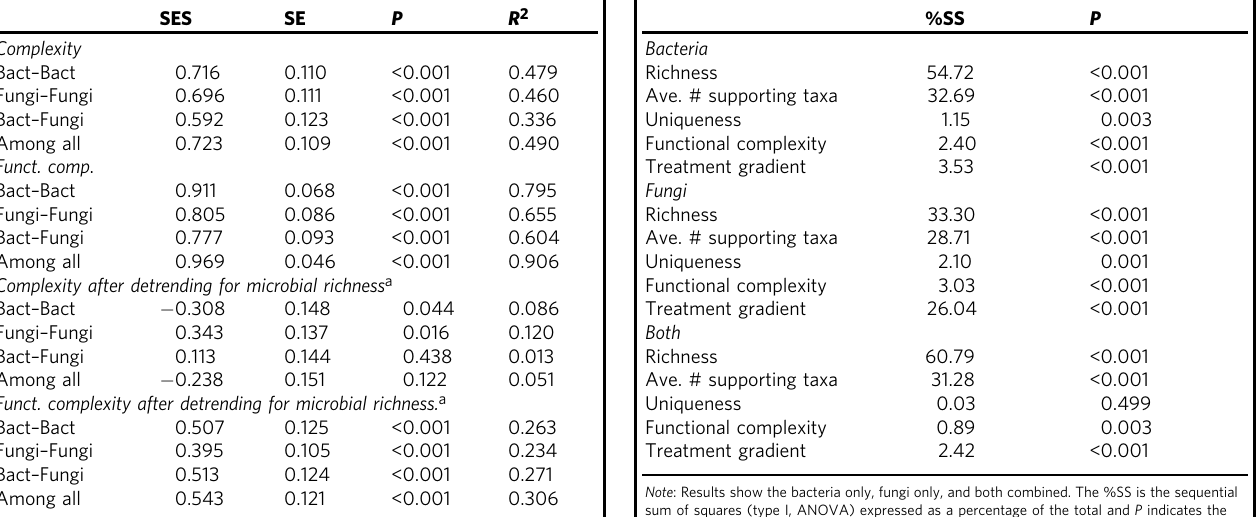
Table 1 Effects of soil microbial network characteristics on ecosystem multifunctionality